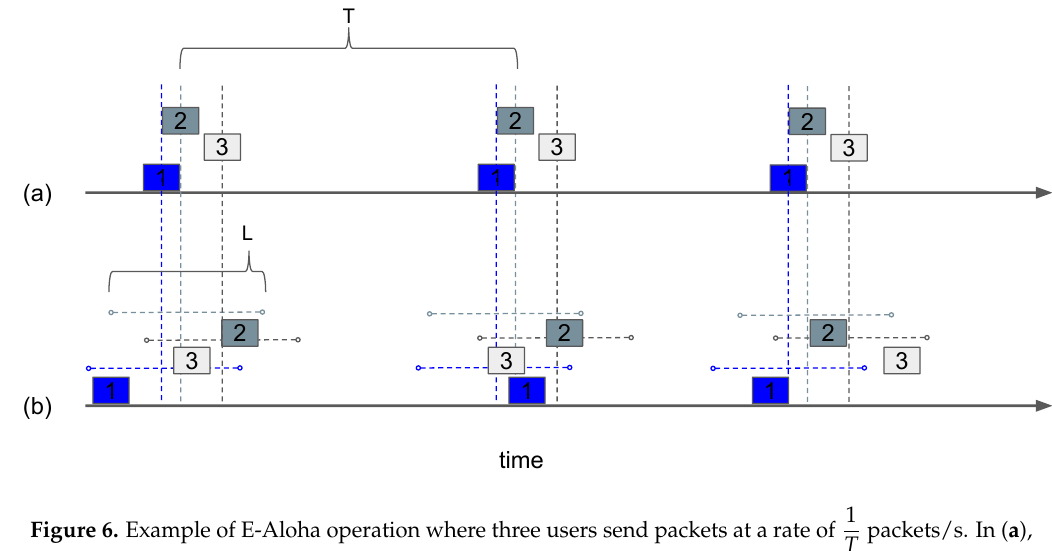
Figure 6. Example of E-Aloha operation where three users send packets at a rate of the users wait a fixed time ( T ), in consequence, there is a permanent collision between the users 1 and 2; whereas in ( b ) there is a time window ( L ) for selecting a new random sending time in order to avoid permanent collisions. Figure adapted from